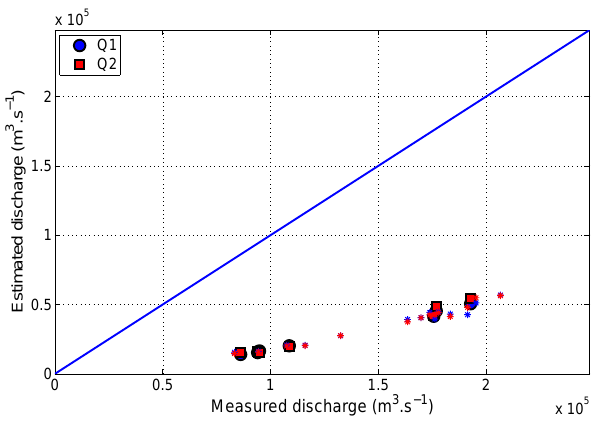
Fig. 2. Comparison of the estimated discharge using Eqs. (8) and (9) and the ADCP discharge measurements at Obidos gauging station.